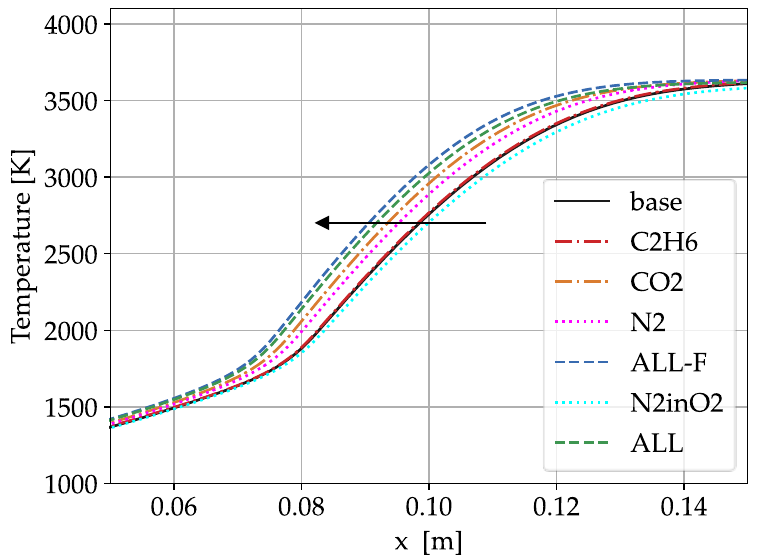
Figure 8. Combustion chamber wall temperature for different pollutants of the fuel and/or oxidizer at the combustion chamber configuration p10 (target pressure 10 MPa). In contrast, the addition of nitrogen into oxygen in contrast seems to have only a negligible effect with a minimal increase. In this case the nitrogen comprises the LOx core in the center of the chamber and, therefore, has no influence on the flow close to the wall.